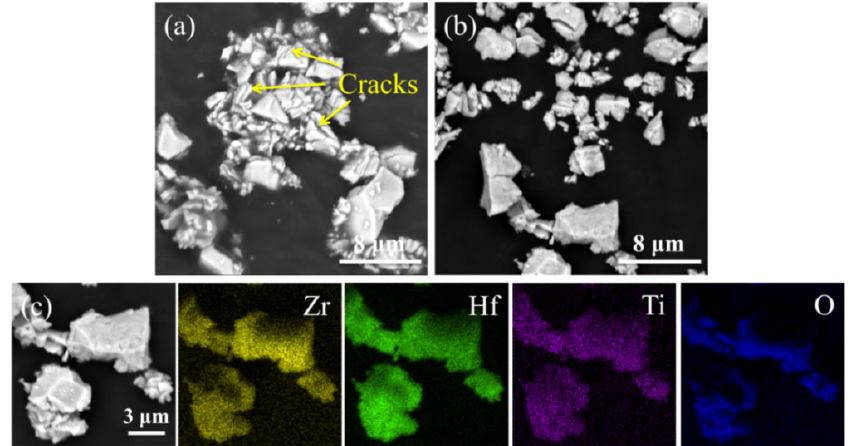
Fig. 7 SEM images of Zr 0.3 Hf 0.5 Ti 0.2 C 0.8 after being oxidized at different temperatures: (a) 500 ℃ and (b) 1200 ℃ ; (c) element mapping of Zr 0.3 Hf 0.5 Ti 0.2 C 0.8 after being oxidized at 1200 ℃